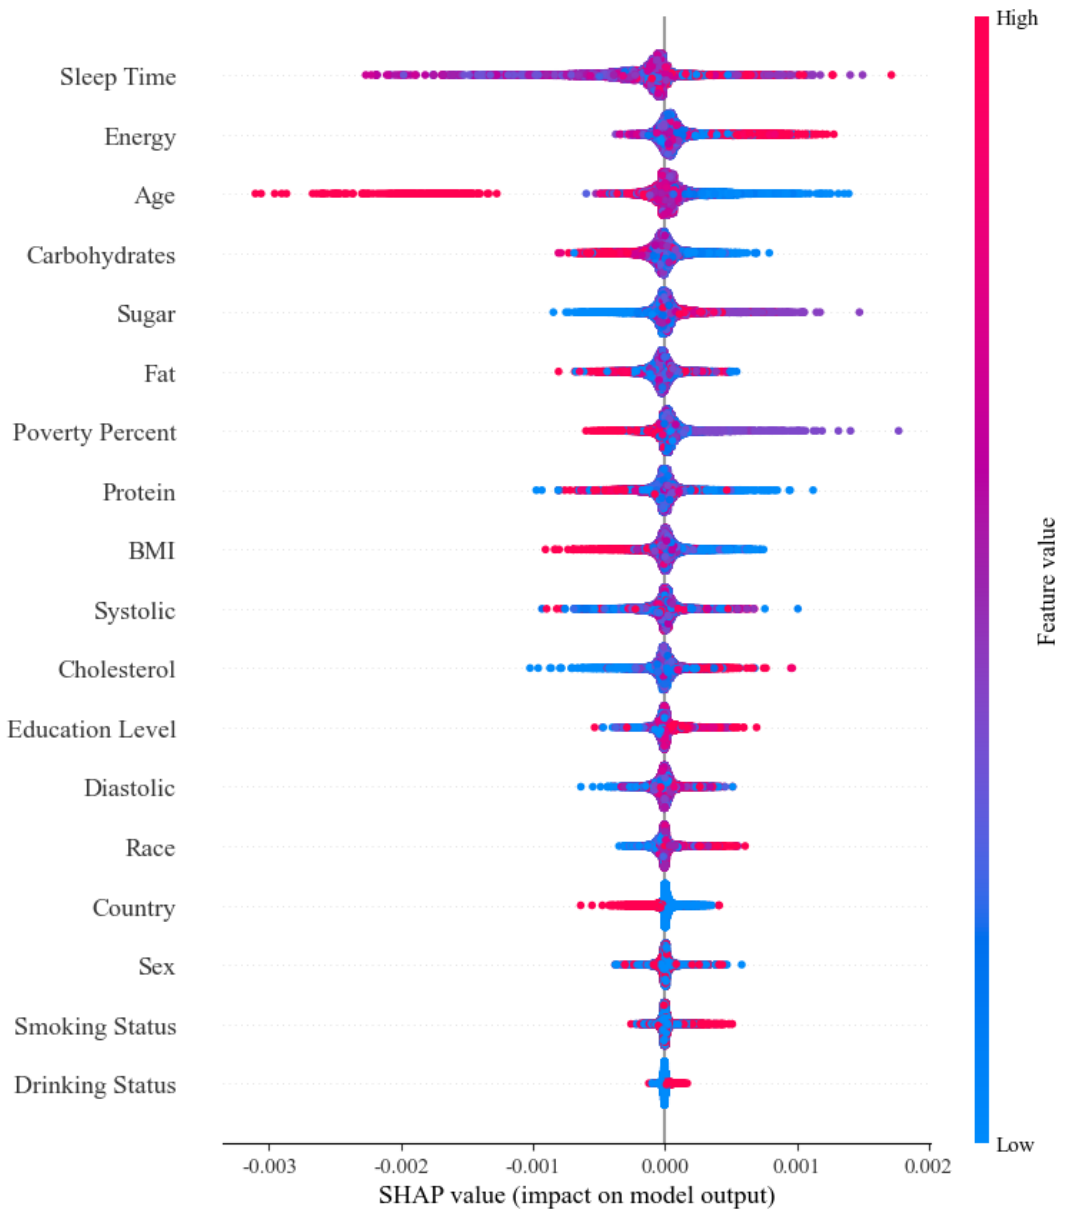
Figure 2. Feature importance of a model based on SHAP values.